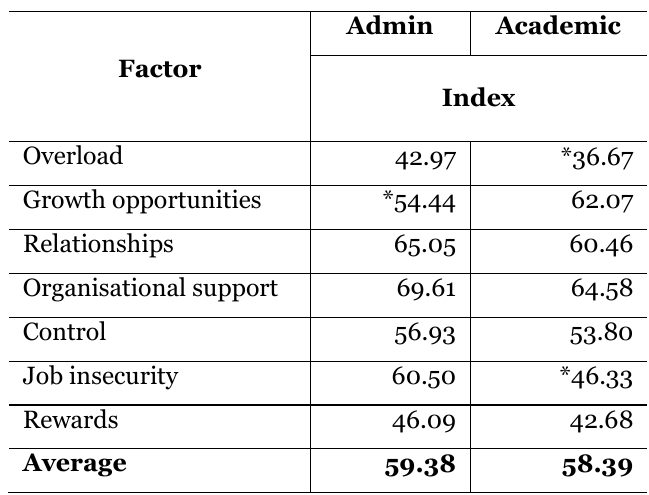
Table 4.1 Occupational Stress and Risk Indices by Factor